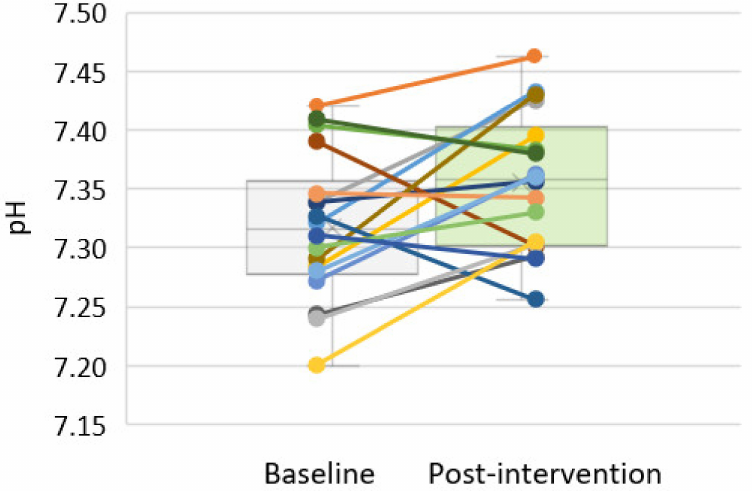
Figure 2. Individual blood pH changes between the baseline visit and after a 3-month sodium bicarbonate administration in non-dialysed CKD 3–5 stages patients ( n =